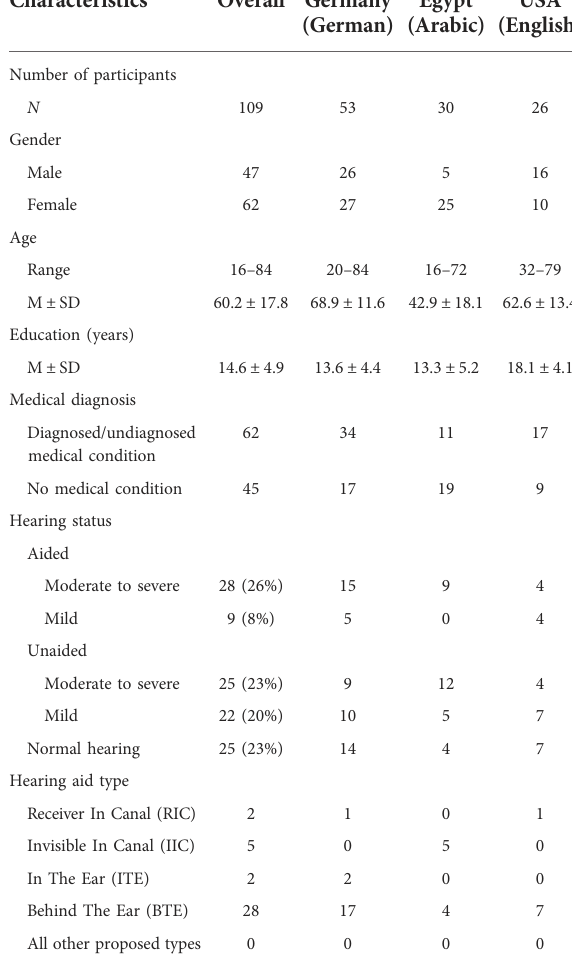
TABLE 5 The sources used in developing the demographic information and Personal Factors items of the HEAR-COMMAND Tool . Item number